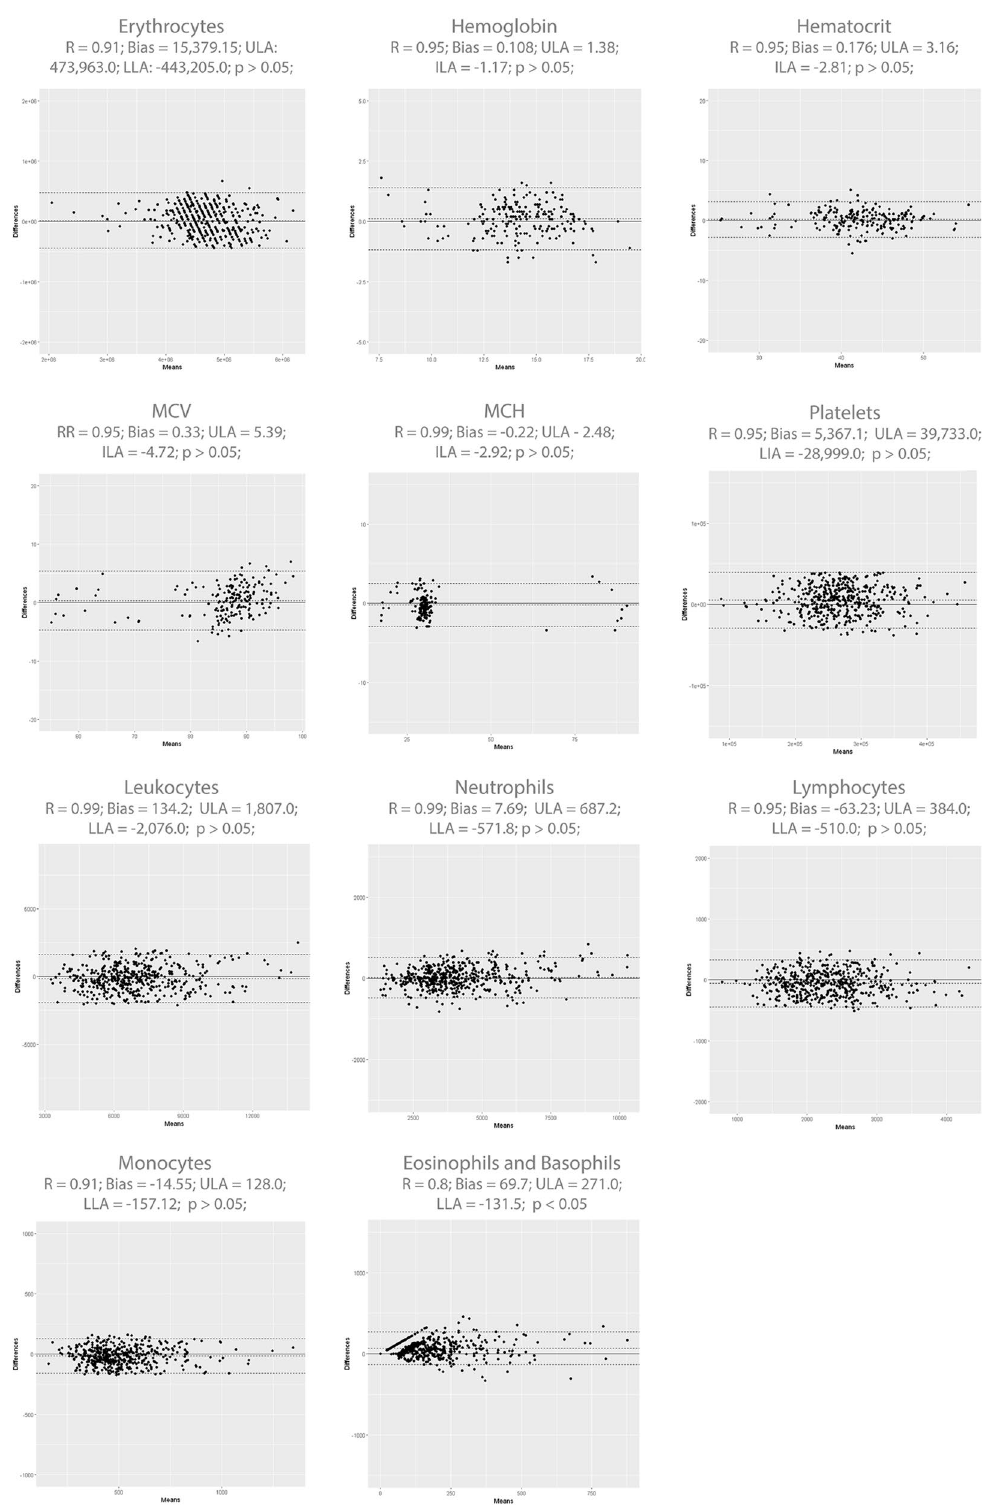
Figure 2. Bland–Altman plot of the method comparison study between the Hilab System and the Sysmex XE-2100. Pearson correlation, bias, Student t test p-value; upper limit of agreement (ULA), and lower limit of agreement (LLA) are demonstrated for each